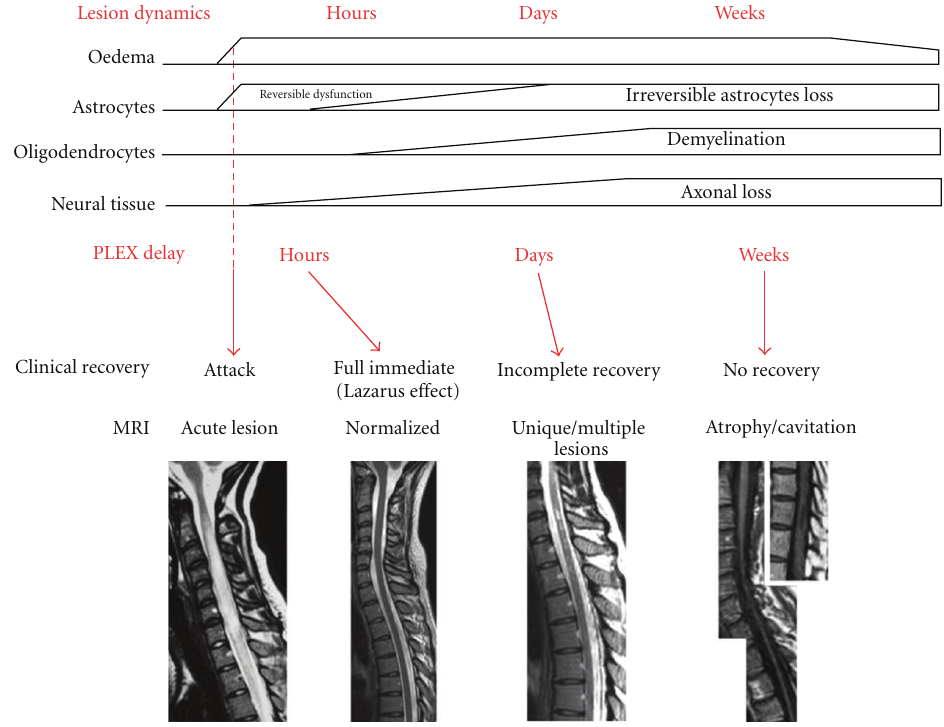
Figure 1: Hypothetical correlation of lesion stages and PLEX e ff ect. The dynamic of the lesion is staged according to pathological data. Clinical and radiological outcome is linked to the delay of PLEX